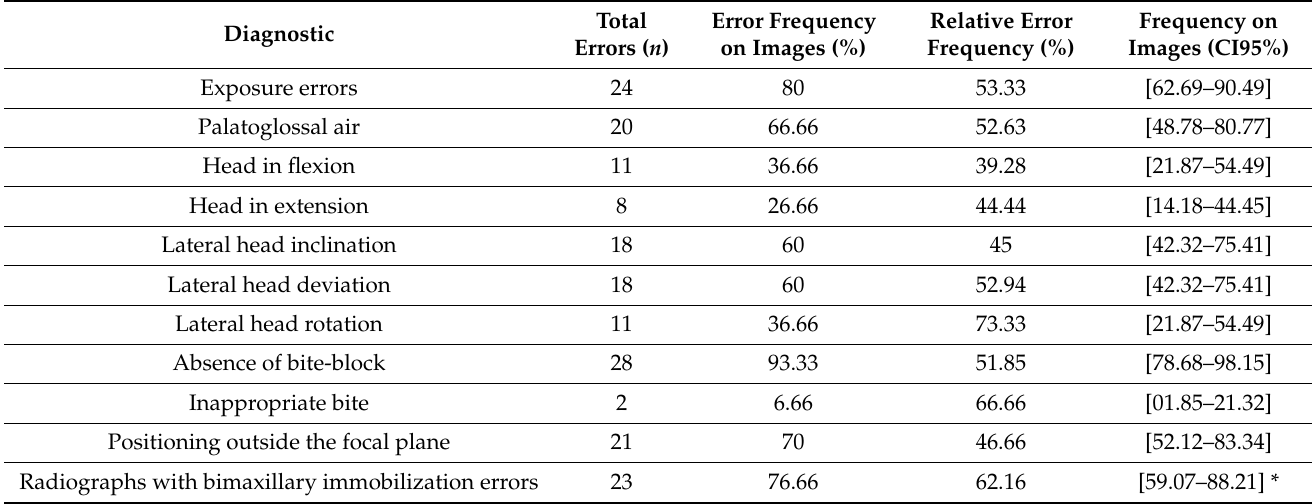
Table 2. Encountered errors in panoramic radiography.